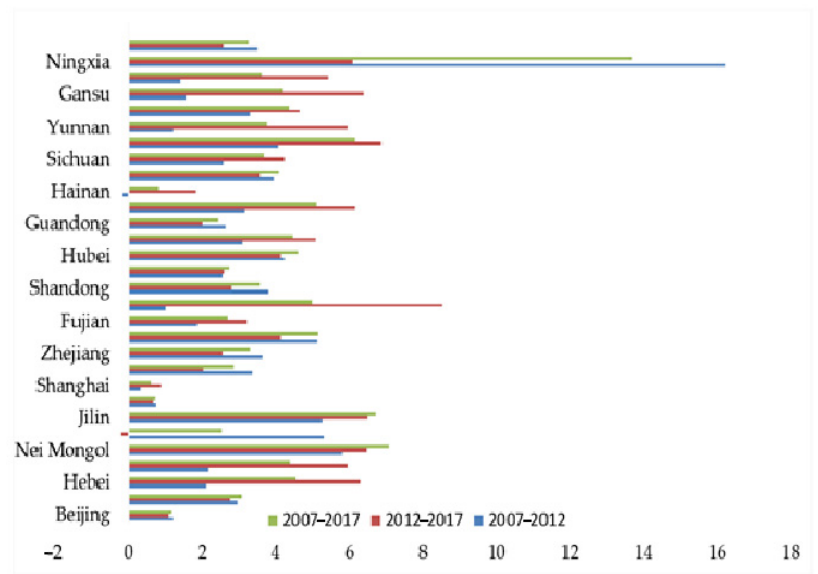
Figure 4. The dynamic degree of coupling coordination development.